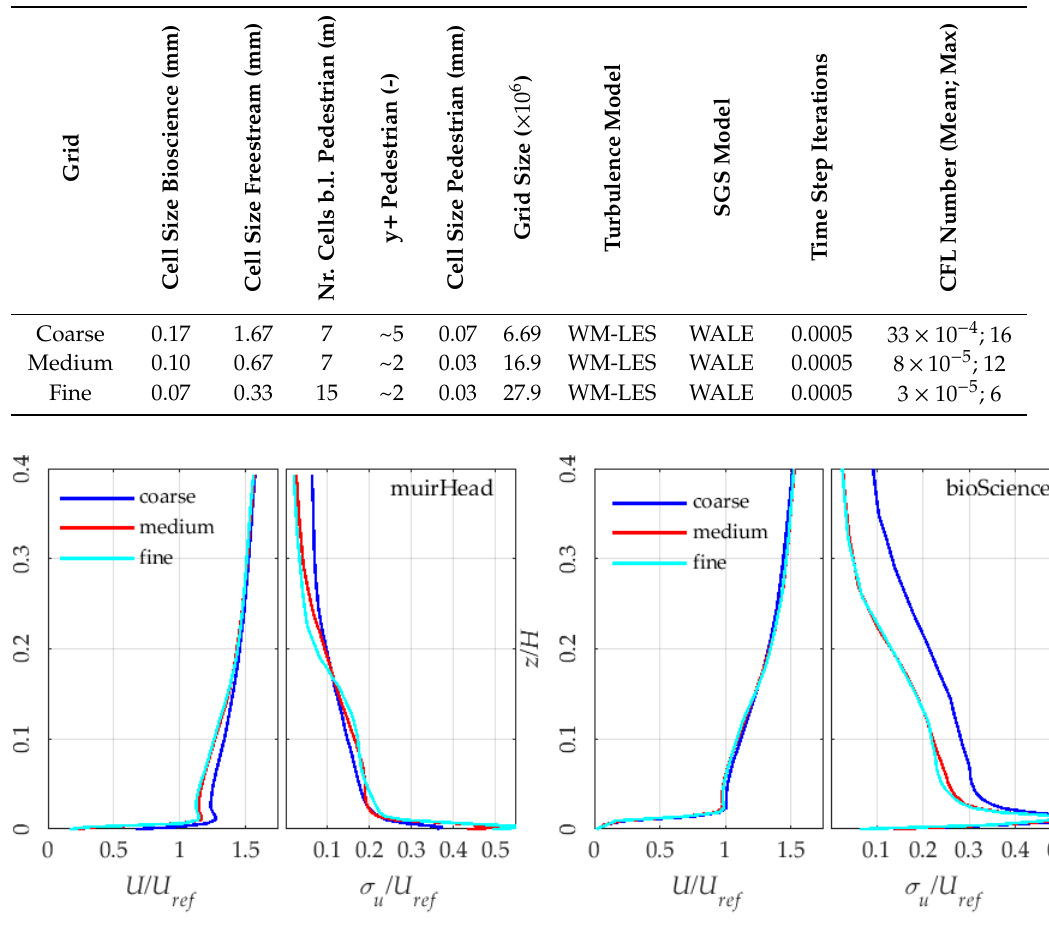
Figure 4. Mesh independency study: Biosciences and the Muirhead buildings. Normalized mean wind speed and standard deviation. z is measured from the roof surface and normalized with H = z B and z M .